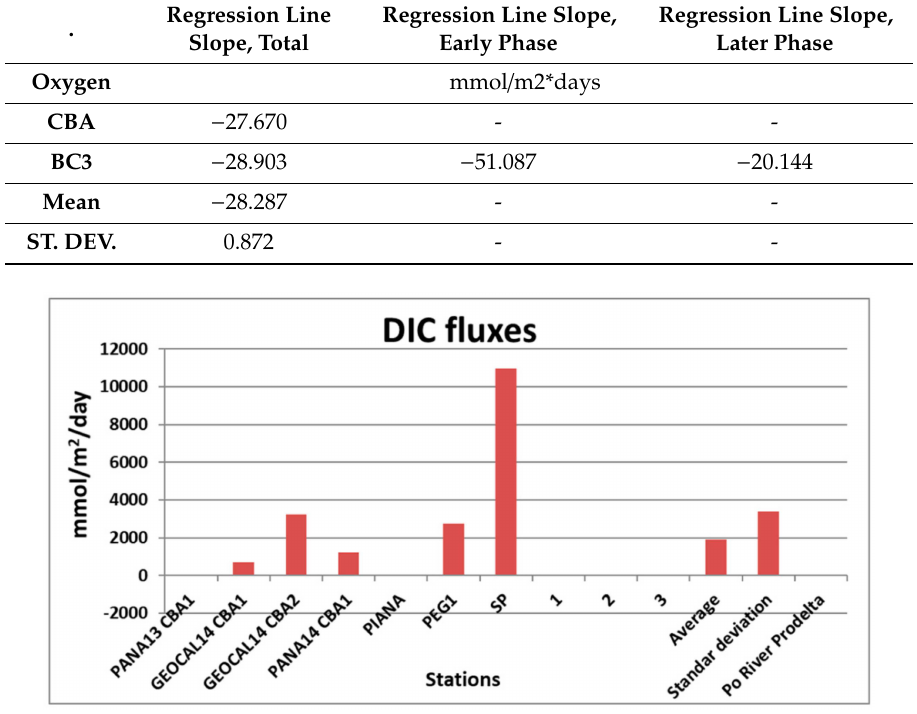
Figure 20. DIC fluxes measured by the CBA in the submarine volcanic area of Panarea and in front of the Po River Prodelta. Table 3. Values of the DIC fluxes at the sediment-water interface measured by the CBA in the submarine volcanic area of Panarea and in front of the Po River